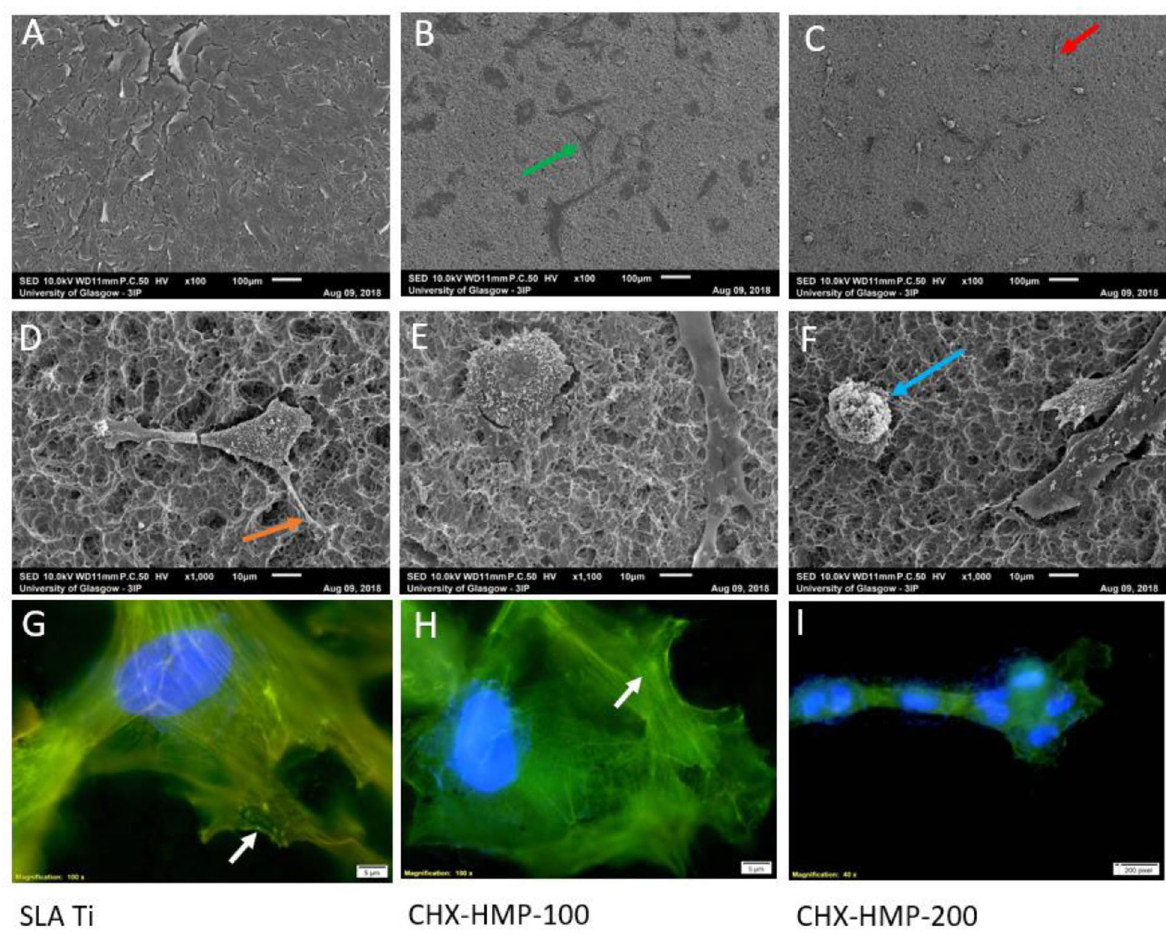
Fig. 4 Adhesion of hMSCs to SLA Ti and CHX-HMP coatings after 7 days ’ growth. SEM images ( A – F ) show different morphologies. Arrows: red — spindle shaped cells; green — stellate morphology; blue — spherical morphology; orange — cell processes interacting with